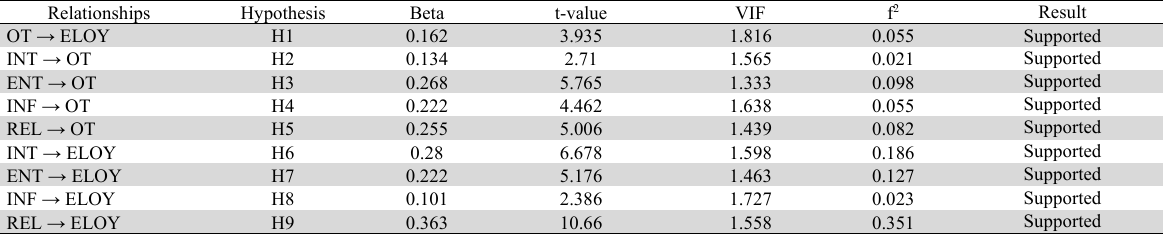
Result of Structural model Relationships